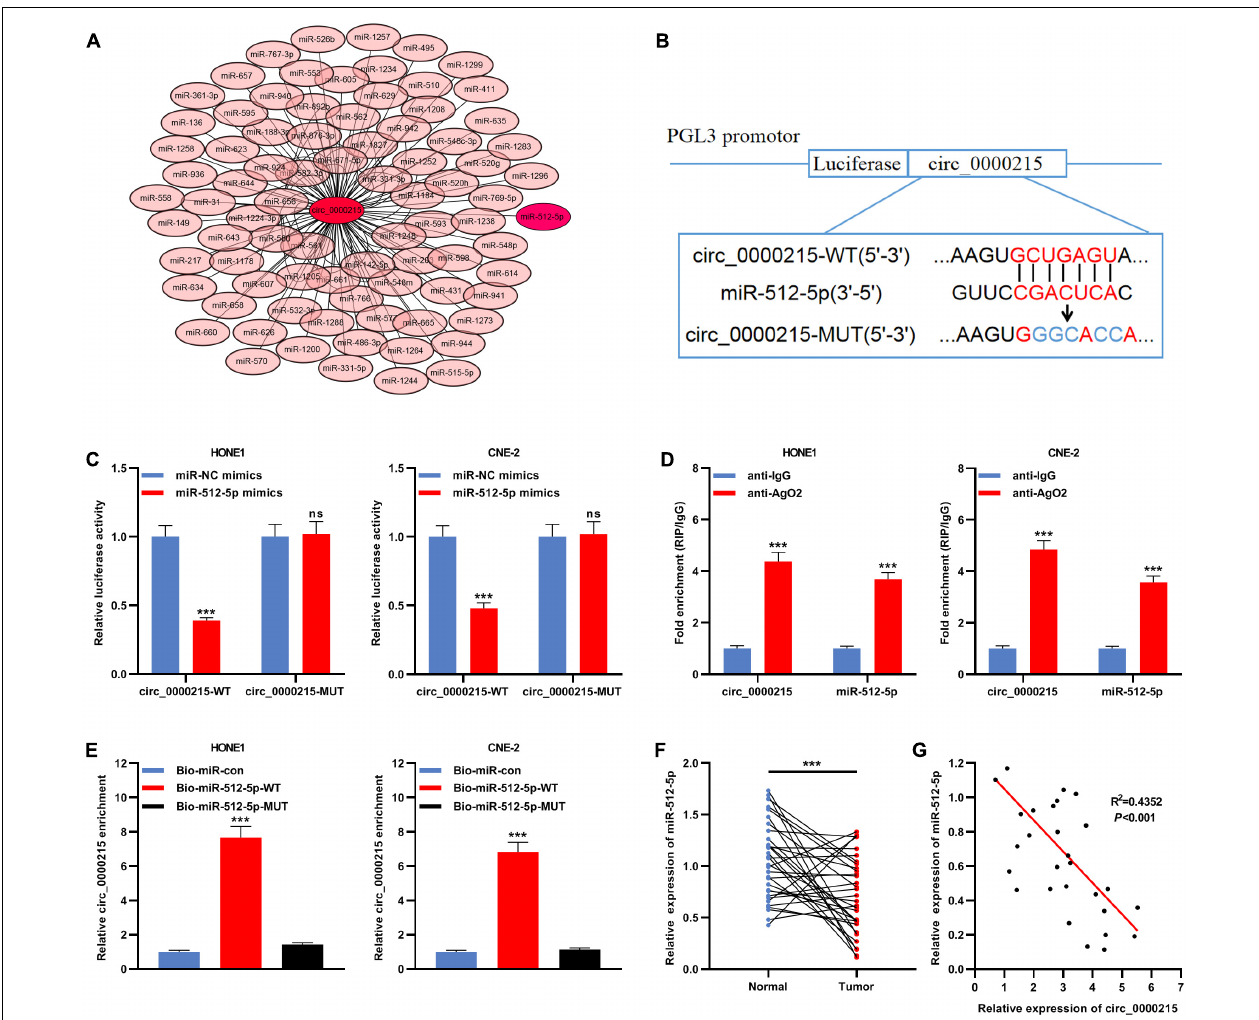
FIGURE 5 | MiR-512-5p is a downstream target of circ_0000215. (A) Bioinformatics analysis was designed to predict the targeted miRNAs downstream of circ_0000215. (B) The schematic diagram showed the putative binding site between miR-512-5p and circ_0000215. (C) Dual-luciferase reporter gene assay was performed to validate the binding site between miR-512-5p and circ_0000215. (D) The complex containing circ_0000215 and miR-512-5p in HONE1 and CNE-2 cells was immunoprecipitated by anti-Ago2 in RIP assay. (E) RNA pull-down assay was carried out to verify the interaction between circ_0000215 and miR-512-5p in HONE1 and CNE-2 cells. (F) qRT-PCR was performed to detect miR-512-5p expression in 32 pairs of NPC tissues and normal tissues adjacent to the cancer. (G) Pearson correlation analysis was performed to analyze the correlation between circ_0000215 and miR-512-5p expressions in NPC tissues. The significance of difference was determined by Student’s t -test or one-way ANOVA.*** P < 0.001, ns differences were not statistically significant. Data from three independent experiments were expressed as mean ± standard